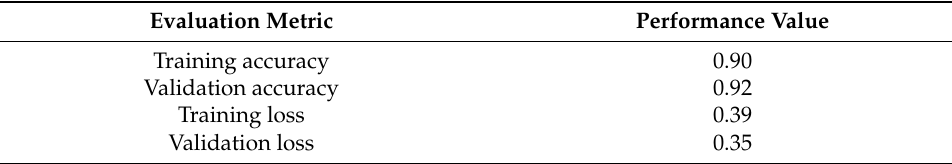
Table 2. Accuracy and loss performance.